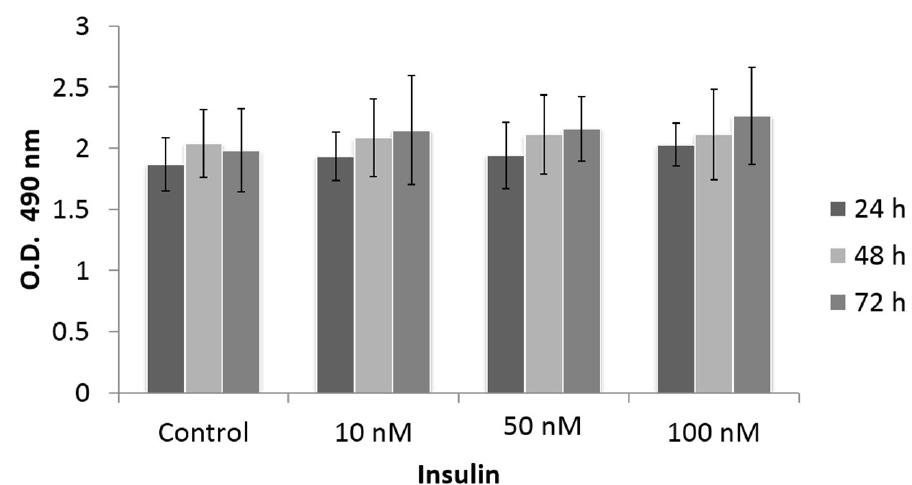
Figure 2. Effect of insulin on the proliferation of HeLa cells with MTS assay. HeLa cells were treated with different insulin doses at different times of stimulation. The histograms represent the mean value ± standard error of the mean (SEM) of optic density values. The control group is cells without treatment. The graphs represent the mean ± SEM of three independent experiments ( n = 6).